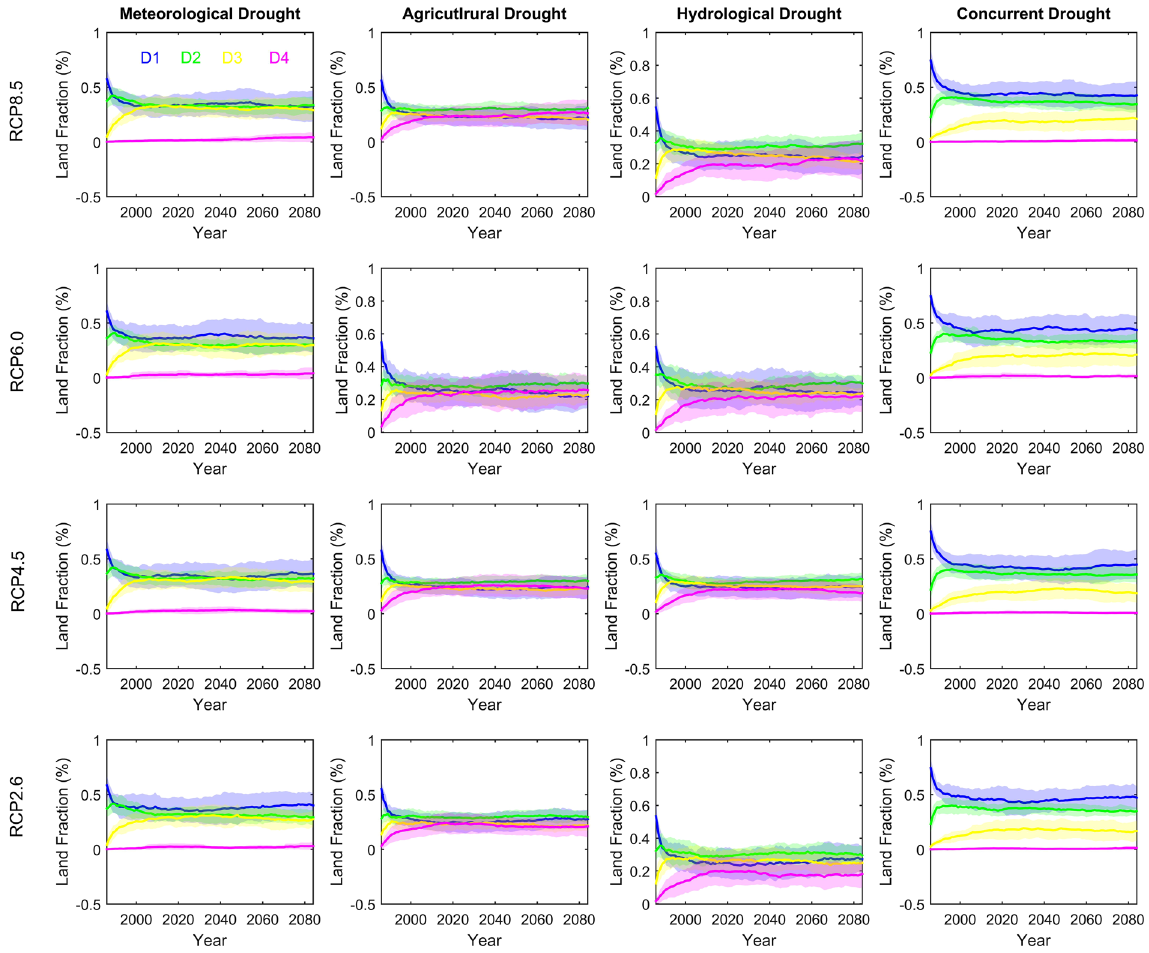
droughts (fourth column) under RCP8.5, RCP6.0, RCP4.5 and RCP2.6 scenarios. D1, D2, D3 and D4 are droughts with durations of 1~3, 4~6, 7~12, > 12 months, respectively. The changes are calculated in a